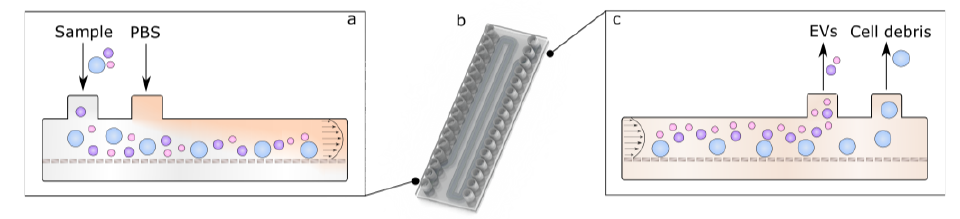
Figure 8. The principle of operation for bifurcated A4F method is described here. ( a ) Start of the device with sample and buffer inlets. ( b ) CAD image of the device showing meandering nature of channels for increased interaction length. ( c ) End of the device with outlets showing the separated result of EVs and large debris.